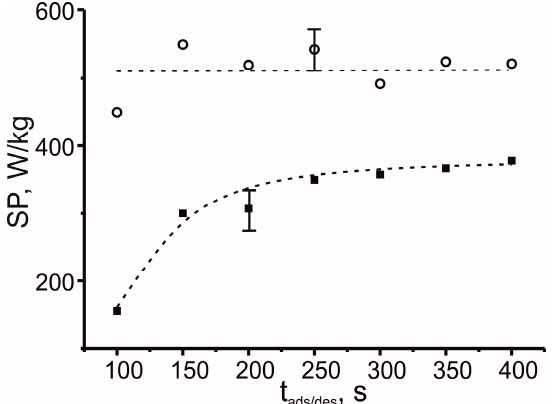
Figure 10. Specific adsorption power SP ads (open symbols) and specific useful power SP us (solid symbols) vs. adsorption–desorption time.